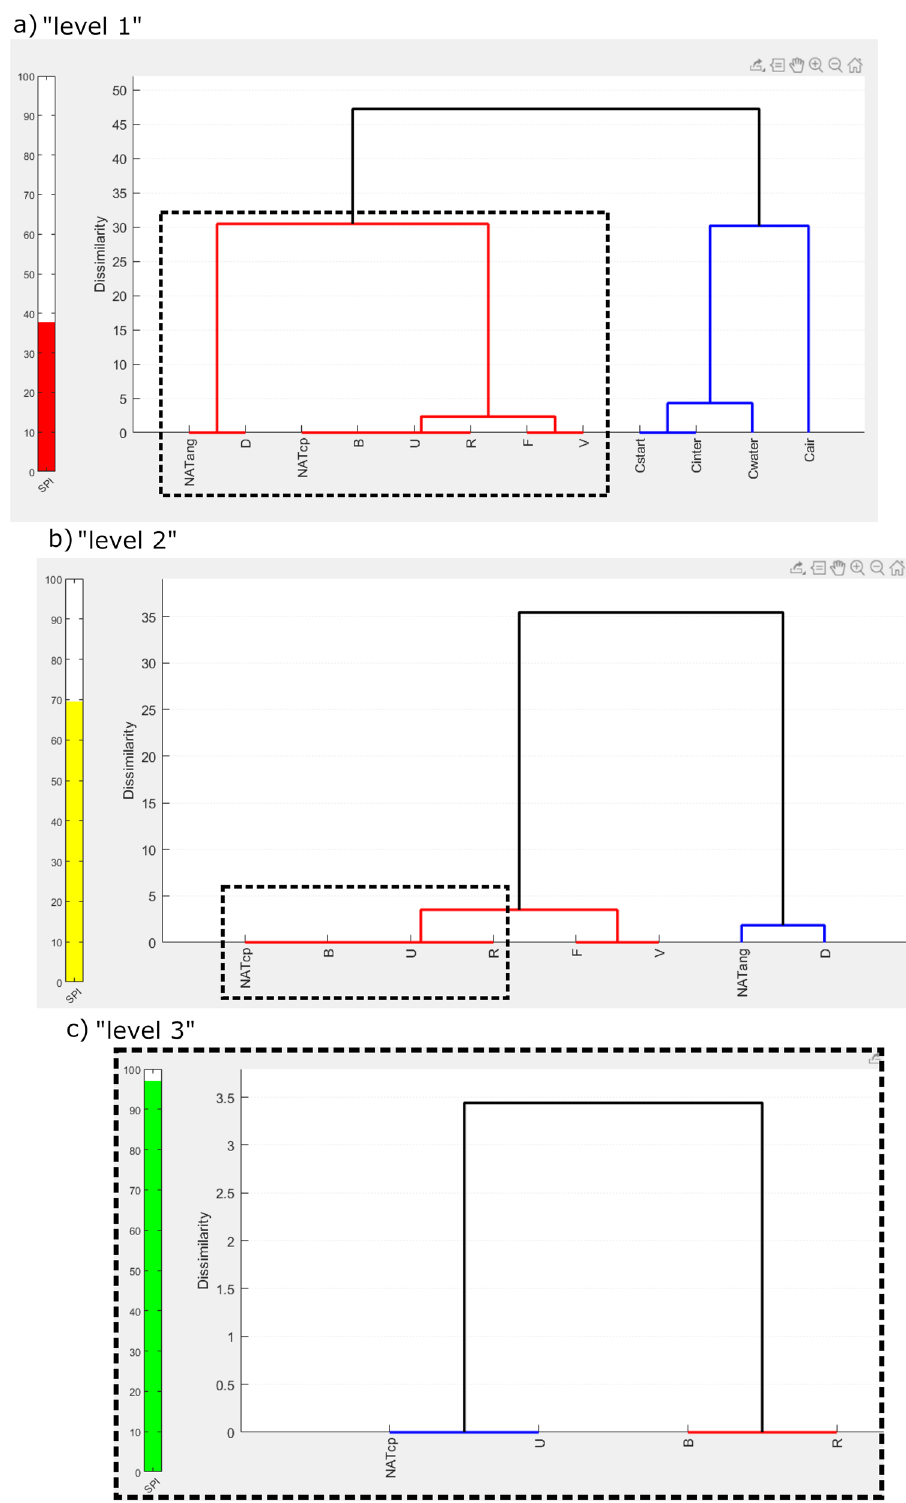
Figure 2. DendroScan screenshot, showing the dendrogram results for different data levels. ( a ) “Level 1” dendrogram in which all studied samples are considered. The red bar on the left indicates a low statistical power index (SPI). The 12 tested samples fall into two main clusters (marked by blue and red colour) and are separated by large dissimilarity values of more than 45. These two sample sets were individually used for further dendrogram computation. ( b ) To obtain the “level 2” dendrogram, all samples of the first main cluster (red group in a) were processed. The yellow SPI bar indicates moderate reliability. Dashed box encloses four samples suggested to be of identical morphology. ( c ) For these four samples a further- downsized (“level 3”) dendrogram was computed. The SPI is already quite high, but according to the DAPM protocol, further t- and e-tests have to be conducted before a statistical equivalence is ultimately